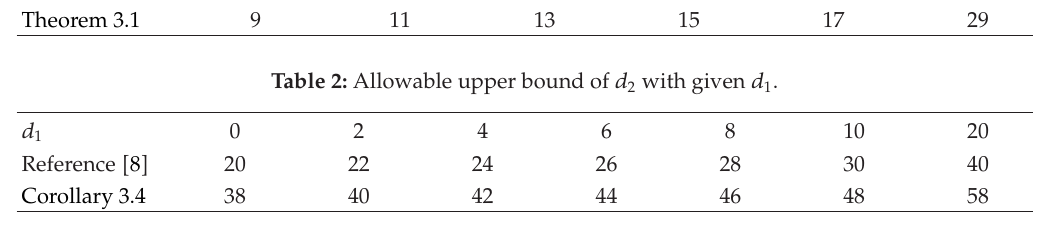
Table 3: Allowable upper bound of d 2 with given d 1